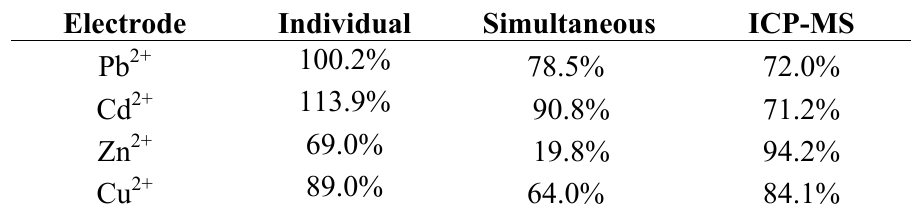
Table 4. Recovery studies of metals determined on the Nafion-G mercury film electrode compared with